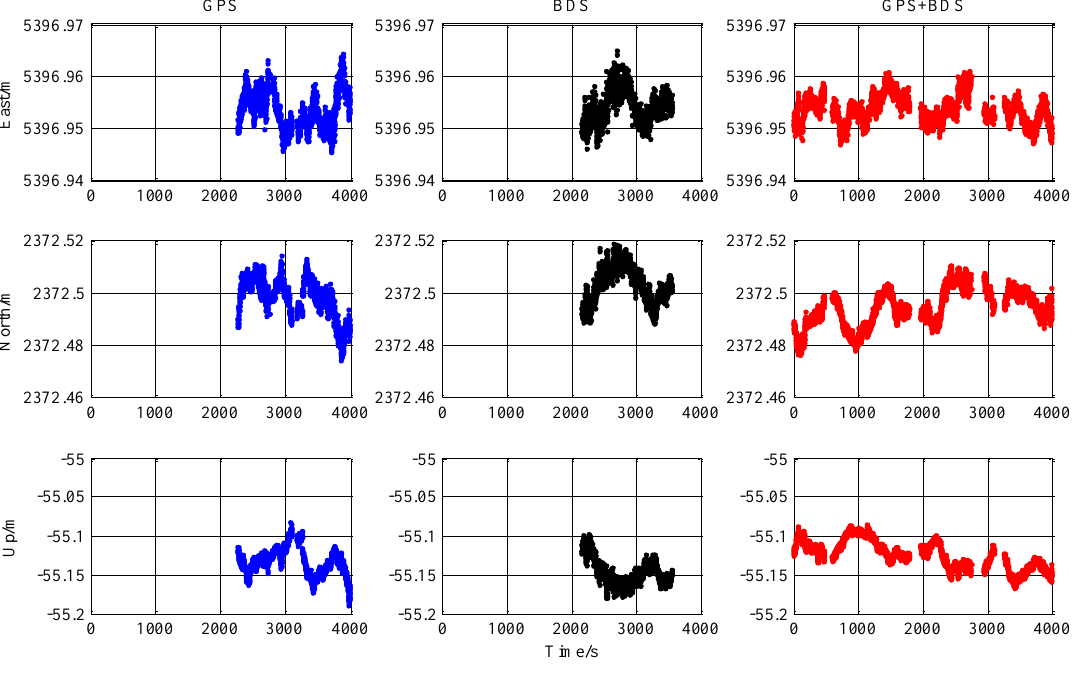
Figure 8. Number of available satellites and ratio vs time of 5.9 km baseline experiment.